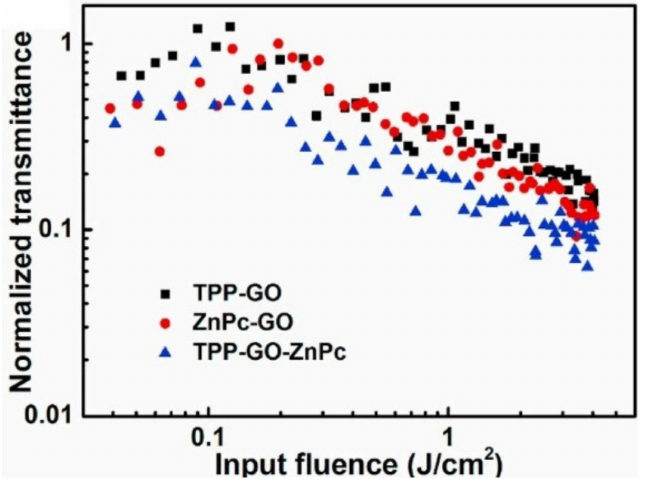
Figure 11. The optical limiting performance of TPP1-GO-ZnPc (Reproduced with permission from ref. [60]. Copyright 2021 Elsevier